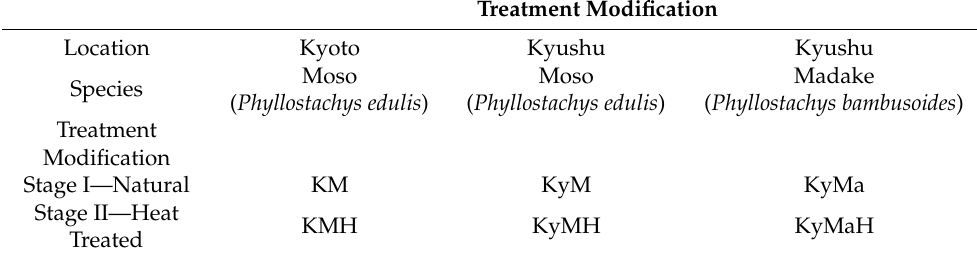
run on an Eppendorf shaker at a speed of 1000 rpm and 37 ◦ C for 24 and 48 h. Then